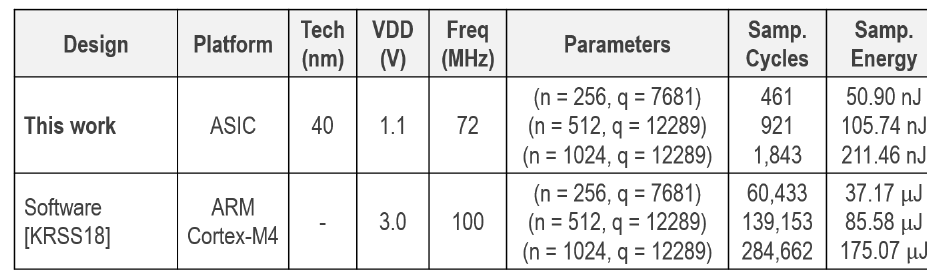
Table 4: Comparison of rejection sampling with software